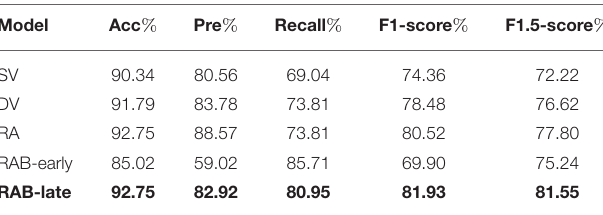
TABLE 3 | Results of ablation experiments in terms of Acc, Pre, recall, and F-score.